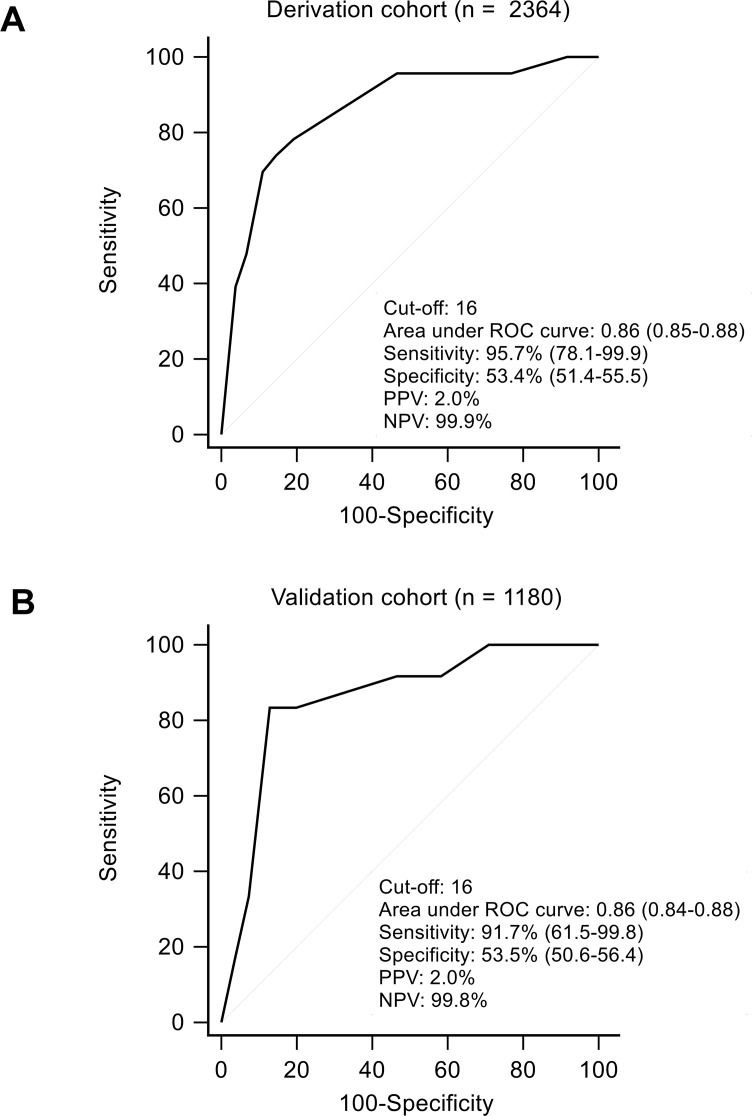
ROC analysis of the DM-HCC risk score in predicting development HCC in 10 years.At the cutoff value of 16, the area under ROC curve was 0.86 (95% CI, 0.85–0.88) in derivation cohort (A) and 0.86 (95% CI, 0.84–0.88) in validation cohort (B). The sensitivity, specificity positive predictive value and negative predictive value were shown with 95% confidence intervals in parentheses.